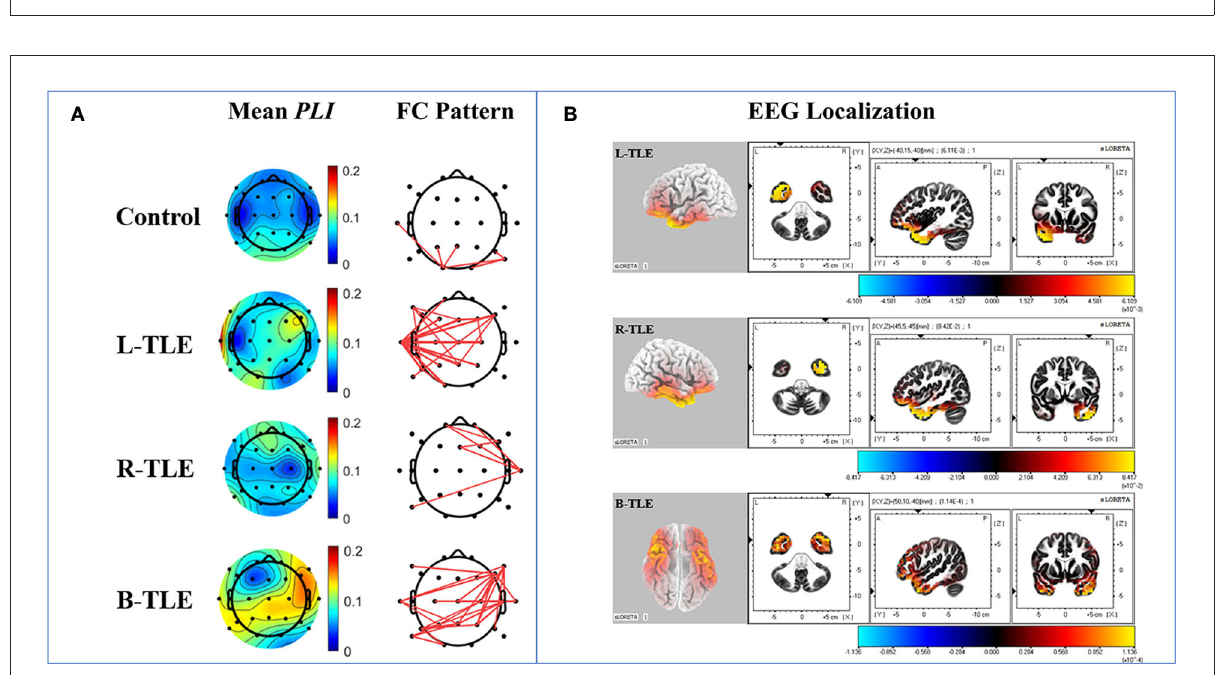
FIGURE2 Diagrams of the functional network in patients with TLE and controls. The graph of the mean phase lag index, functional connection pattern (A) and sLORETA (B) displayed ipsilateral enhancement in frontotemporal regions in patients with TLE.